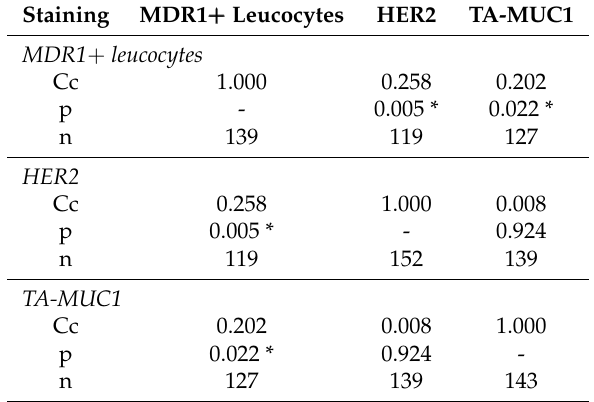
Table 2. Correlation analysis between MDR1 + leucocyte infiltrate and other pathological markers. Staining MDR1 +++ Leucocytes HER2 TA-MUC1 MDR1 +